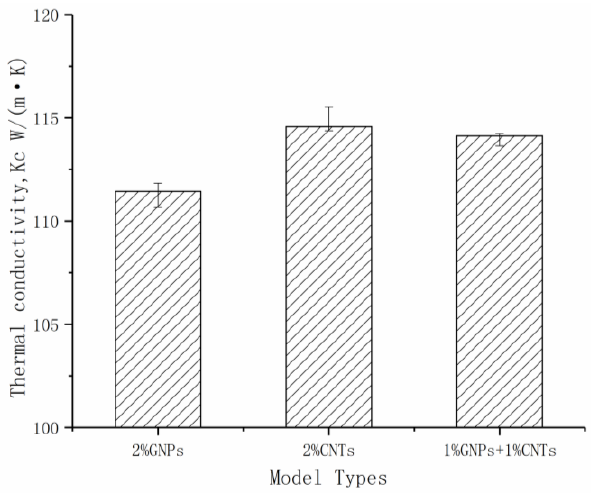
Figure 14. The K c values of three different addition phase